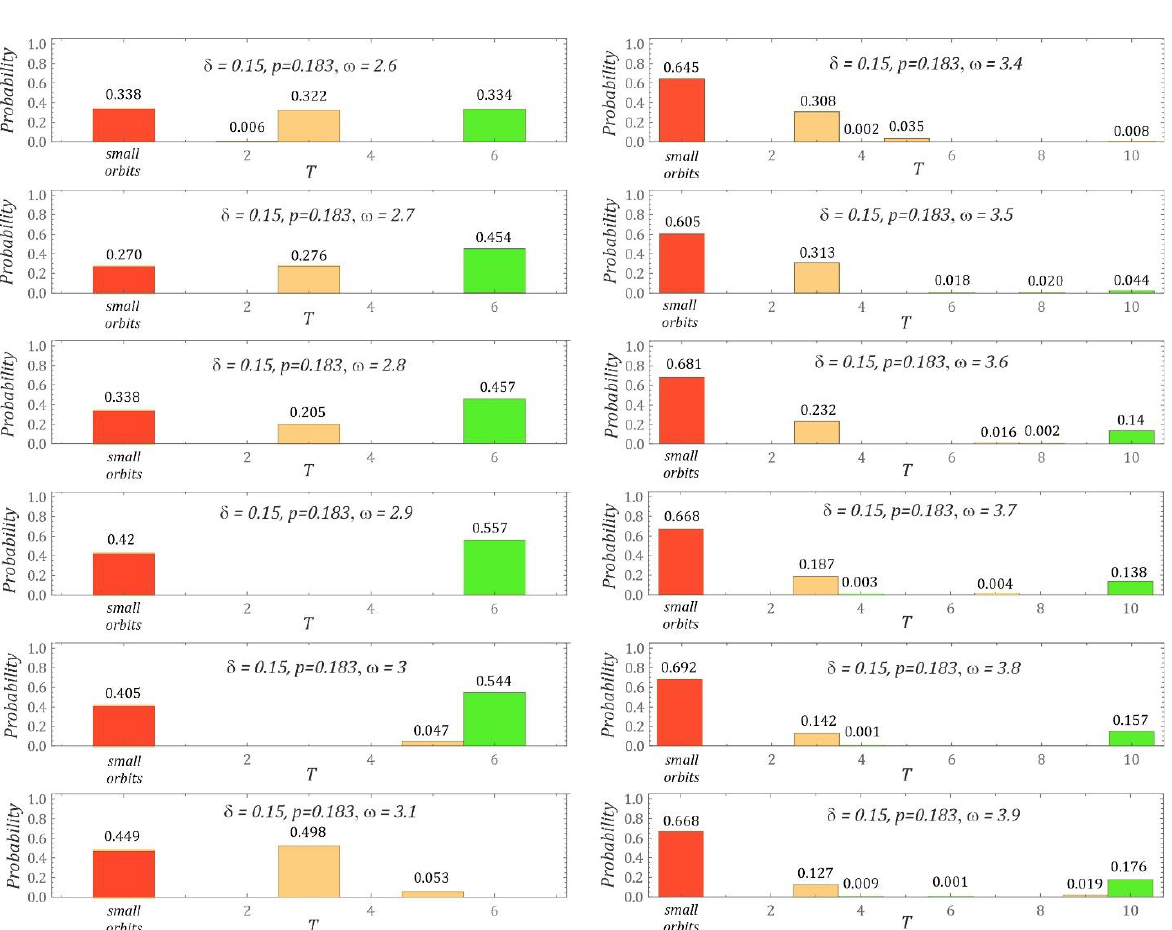
Figure 7. Numerical results showing the influence of potential asymmetry on the probability of oc- currence of particular solutions for different values of δ (δ = 0.0, 0.15, 0.30, and 0.60, respectively). The horizontal axis T is related to the excitation period, and it is the unit of the response periodicity in the response probability diagrams. The colors represent the different orbits of δ parameter.